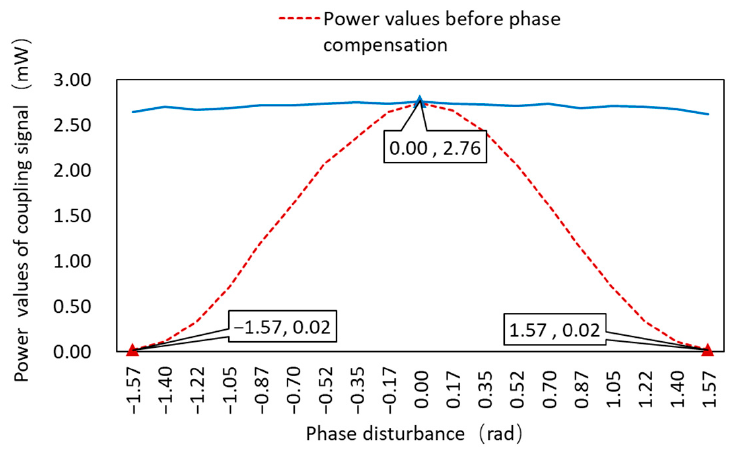
Figure 12. Power values before and after phase compensation.